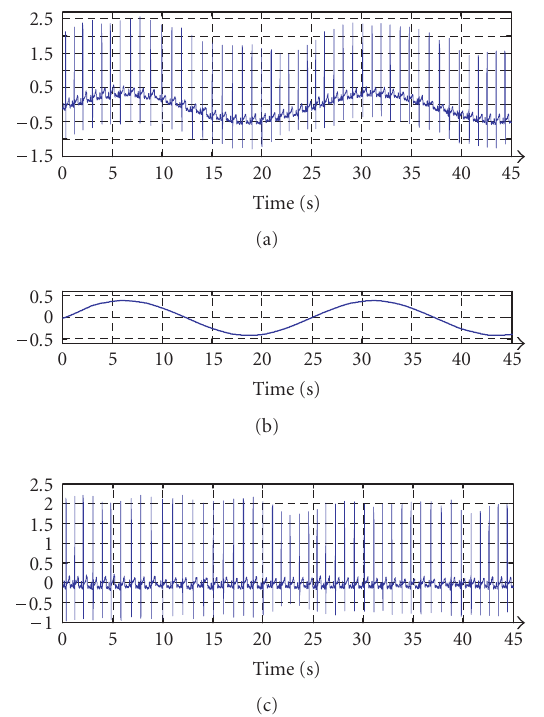
Figure 9: Baseline removal from ECG plus sine-wave. (a) ECG sig- nal with added sine-wave, (b) estimated baseline drift, (c) ECG after removing the baseline.